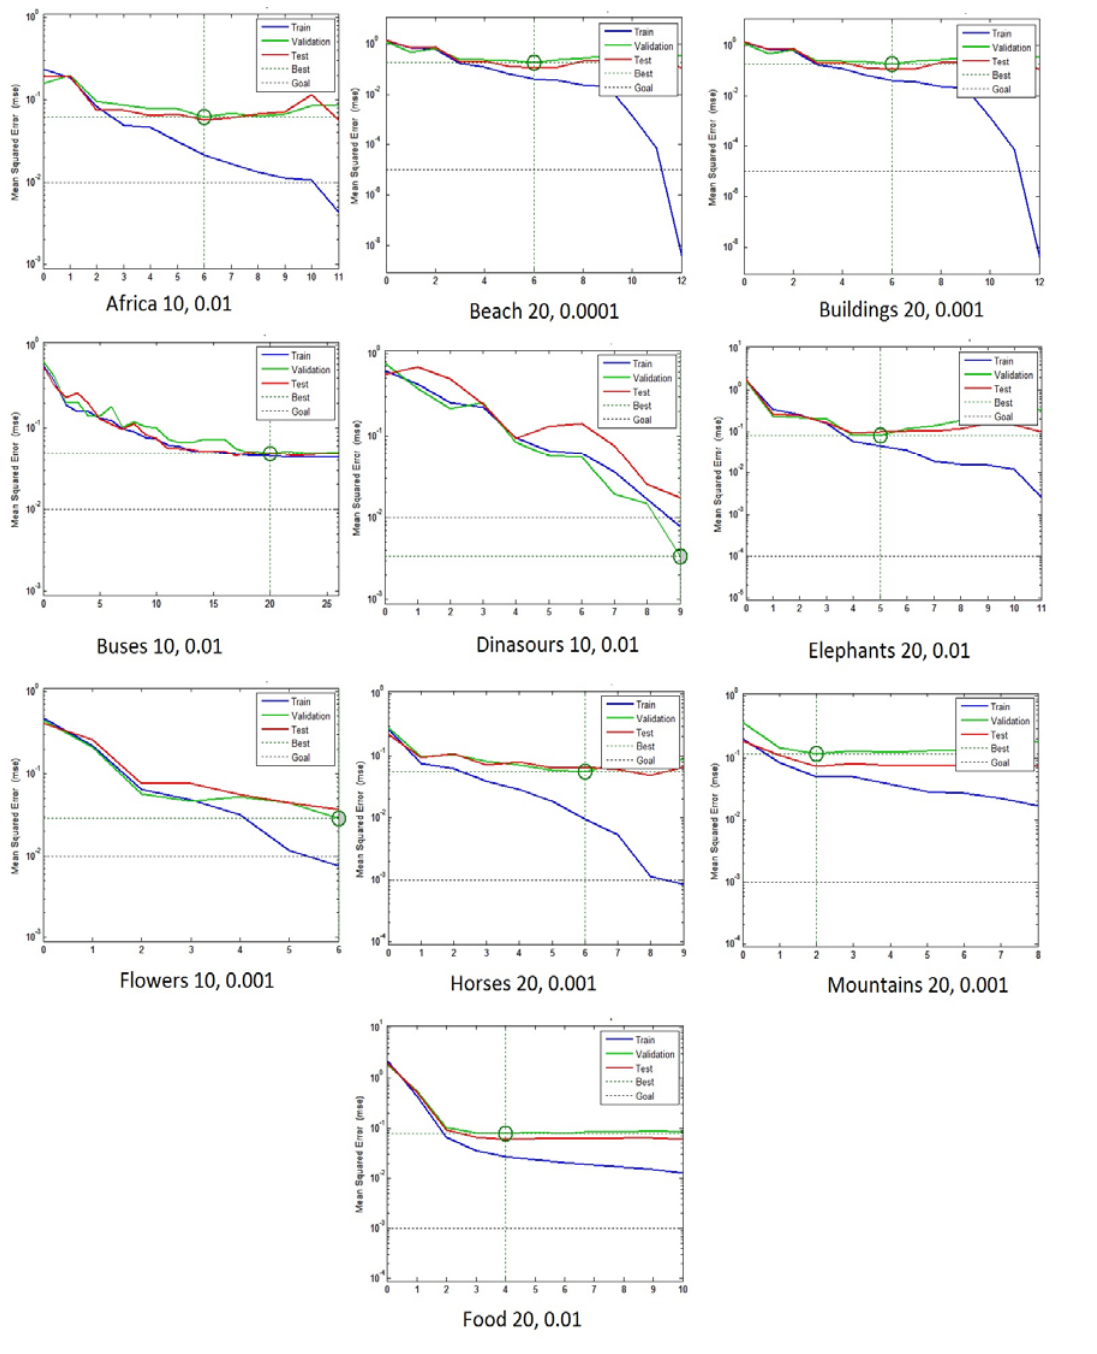
Fig. 7. Class specific Neural Networks training performance graph. Plotted mean squared